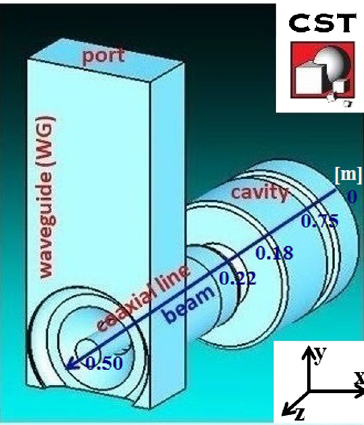
FIG. 2. A computational gun model in CST-MWS for fre- quency domain calculation. The inset numbers indicate the longitudinal positions along the cavity